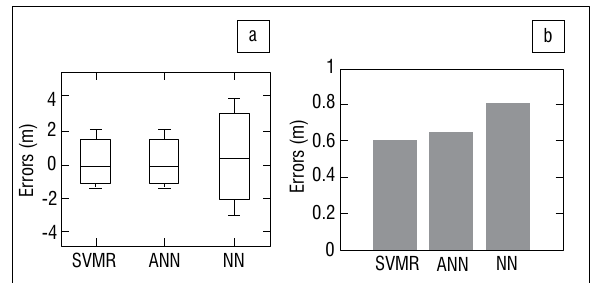
Figure 9: Plots showing discrepancies between the observed heights and the heights predicted using (a) support vector machine regression (SVMR), (b) artificial neural network (ANN) and (c) nearest neighbour (NN) methods.